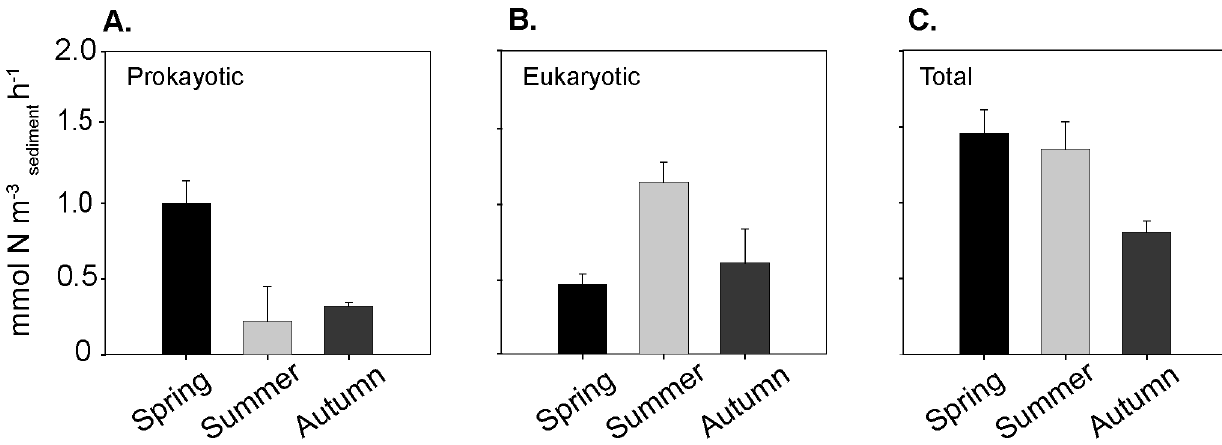
Figure 3. Seasonal patterns in DNRA rates mediated by the prokaryotic and eukaryotic community. A) Eukaryotic DNRA rates B) Prokaryotic DNRA rates C) Overall DNRA rates. Total rates were determined from the incubation amended with 15 NO 3 2 . Prokaryotic rates were determined after addition of the eukaryote inhibitor cycloheximide. Eukaryotic rates were calculated by subtracting prokaryotic rates from total rates. Error bars are SD (n=3)